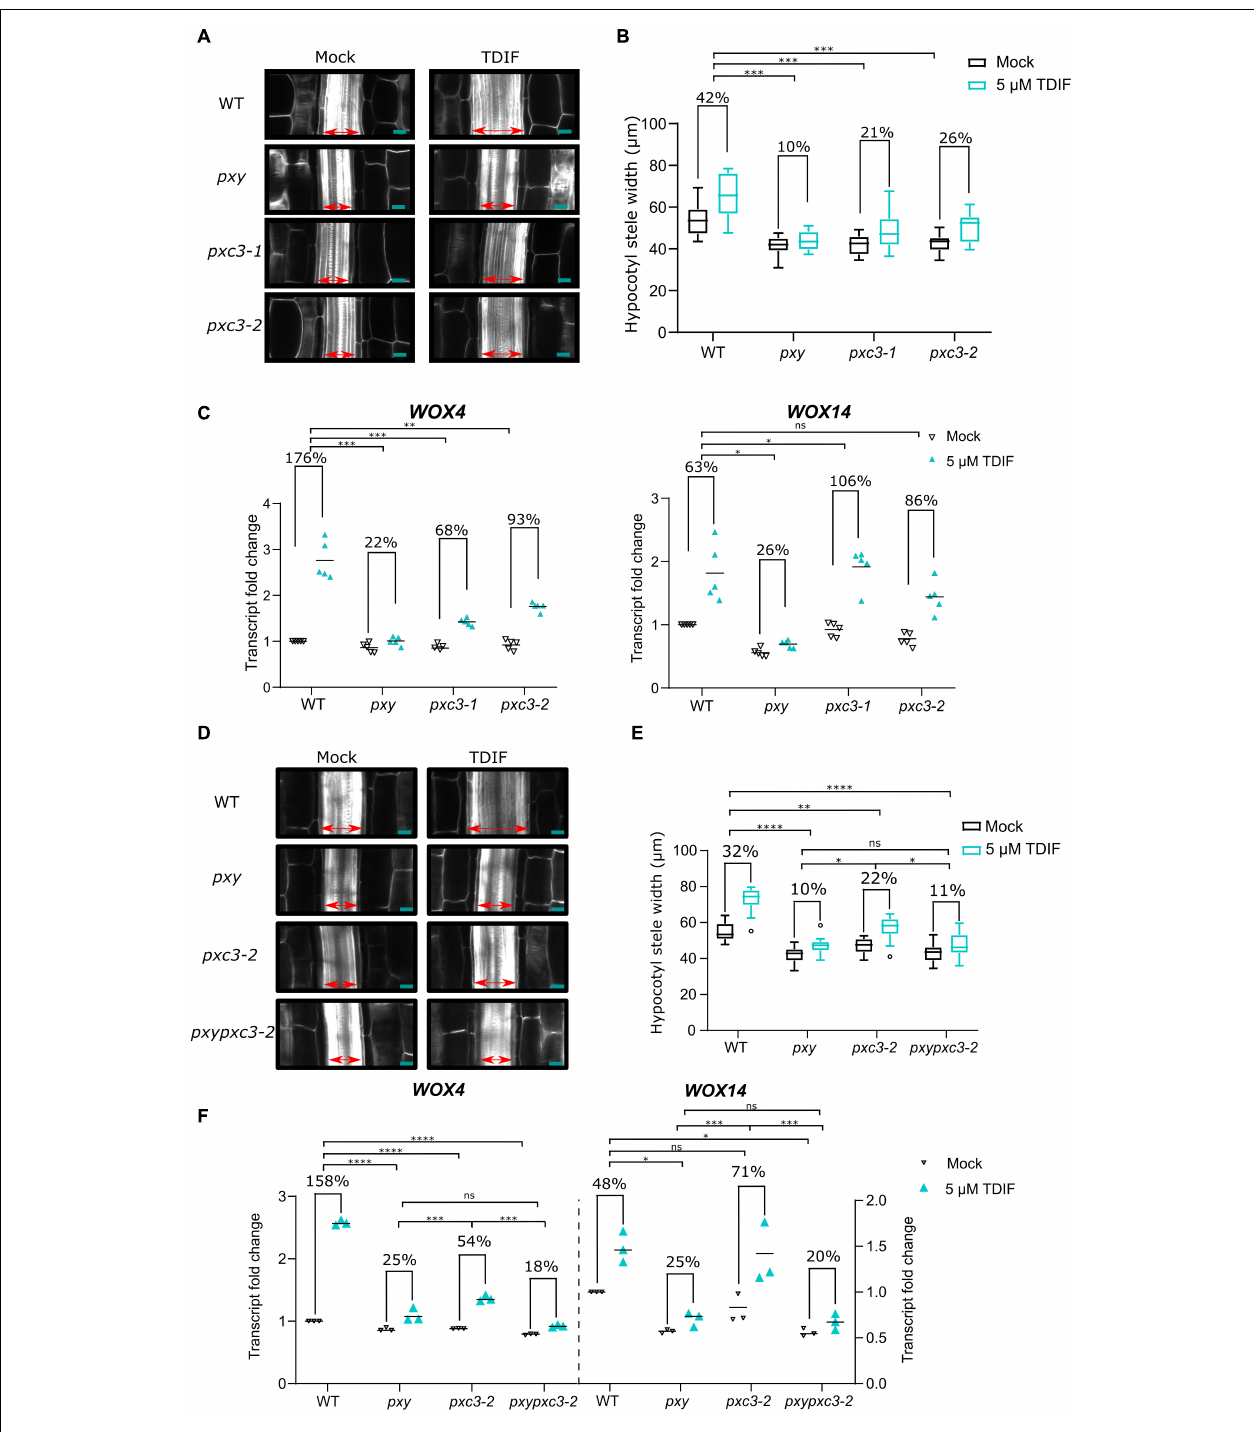
FIGURE 3 | pxc3 mutants have reduced sensitivity to TDIF peptide treatment. (A) Longitudinal confocal sections of wild type and mutant hypocotyls (7 DAG seedlings) treated or not with the TDIF (5 µ M) peptide for 4 days as indicated. The double-sided arrow indicates the stele width. Scale bars represent 20 µ m. (B) Quantification of the stele width ( n ≥ 15). This experiment was done three times. In two out of three replicates, a significant interaction between treatment and genotype was found for pxc3 mutants compared to wild type. Numbers indicate fold change in the mean stele width relative to the untreated sample for each genotype. A two-way ANOVA followed by a Dunnett’s test was performed and the asterisks indicate a significant genotype and treatment interaction compared to wild type (*** P < 0.001). (C) WOX4 and WOX14 transcript levels after 8 h TDIF treatment of wild-type and mutant seedlings. Fold change relative to wild type (mock) is shown. Numbers indicate fold change in the mean value (line) relative to the untreated sample for each genotype ( n = 5 independent replicates). A one-way